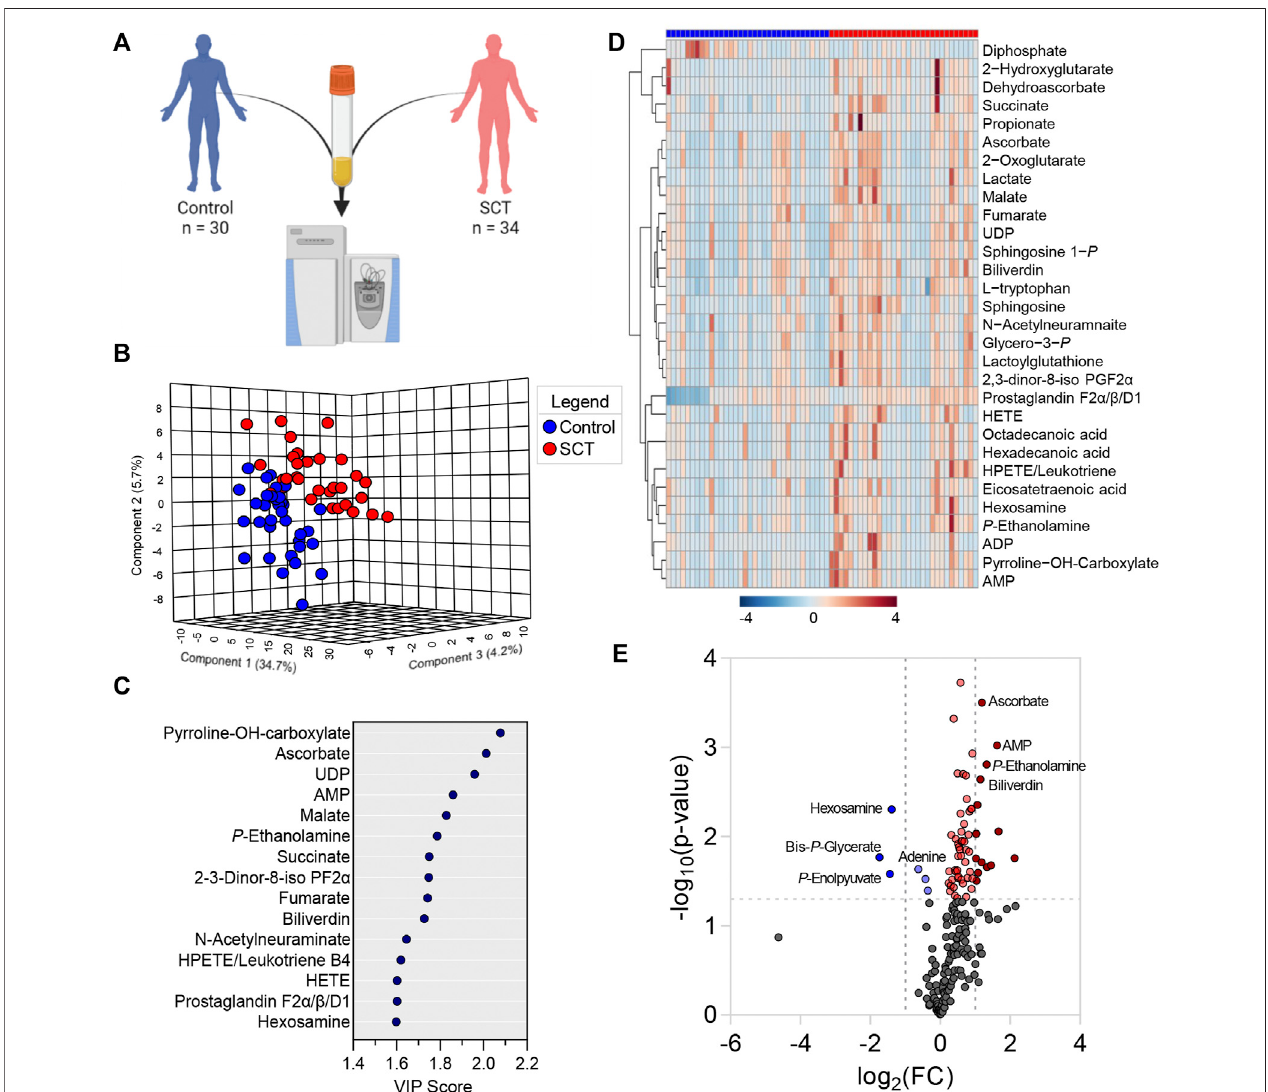
FIGURE 2 | Metabolomics analyses were performed on plasma from healthy controls and subjects with sickle cell trait (A). Statistical analyses showed distinct metabolic pro fi les between the two groups, as gleaned by multivariate principal component analysis (B) , variable importance in projection (C) , hierarchical clustering analysis (D) , and volcano plots (E)